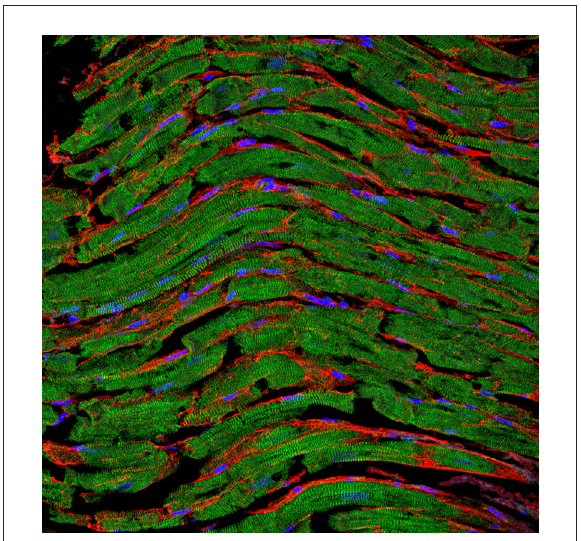
FIGURE1 Representative fluorescence staining of paraffin-embedded cardiac tissue section derived from an autopsy patient. The clear sarcomere structure of cardiomyocytes is shown in green ( α -actinin staining), nuclei are shown in blue (DAPI staining), and the fibrotic tissue between cells is highlighted in red (WGA staining). Image was kindly provided by Hanna